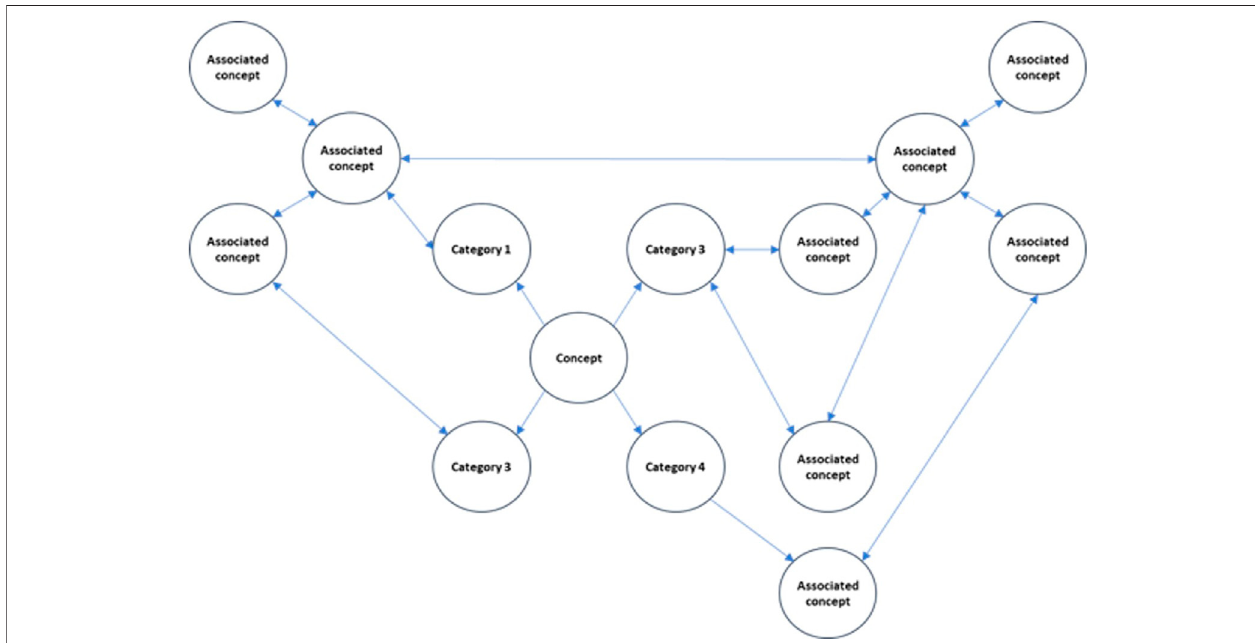
FIGURE 1 | Structure of the mind